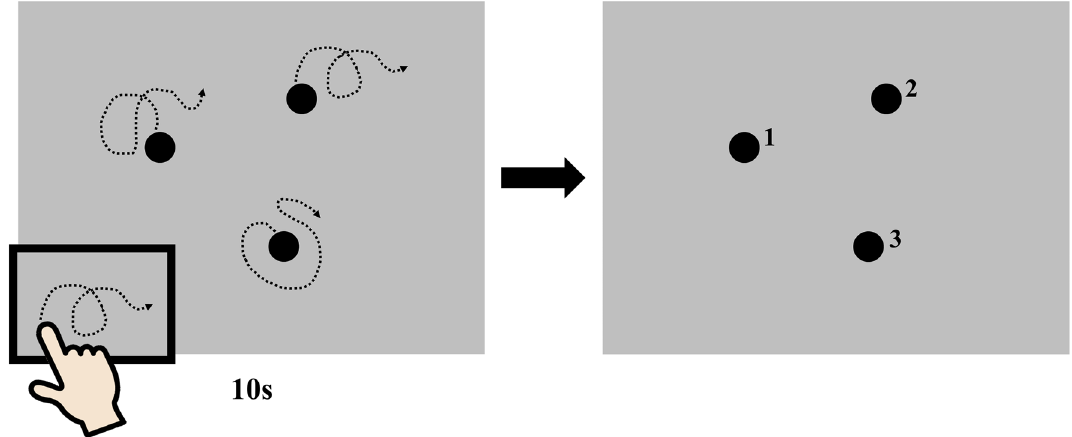
Figure 1. Action-outcome regularity detection task. The participant was allowed to move their finger freely on a touchpad to elicit motion of three dots for 10 s, and then stated which dot they thought they could control, i.e., the movement of which dot corresponded to their own finger movements. Two dots moved according to the pre-recorded movements of one of the authors, and one target dot moved in a hybrid direction that mixed the motion of the participant’s finger and the pre-recorded movements in a ratio of 0:100; 20:80; 40:60; 50:50; 60:40; 80:20; or 100:0. The dashed curves with arrows show the trajectories of the dots and the movements of the participant’s finger on the